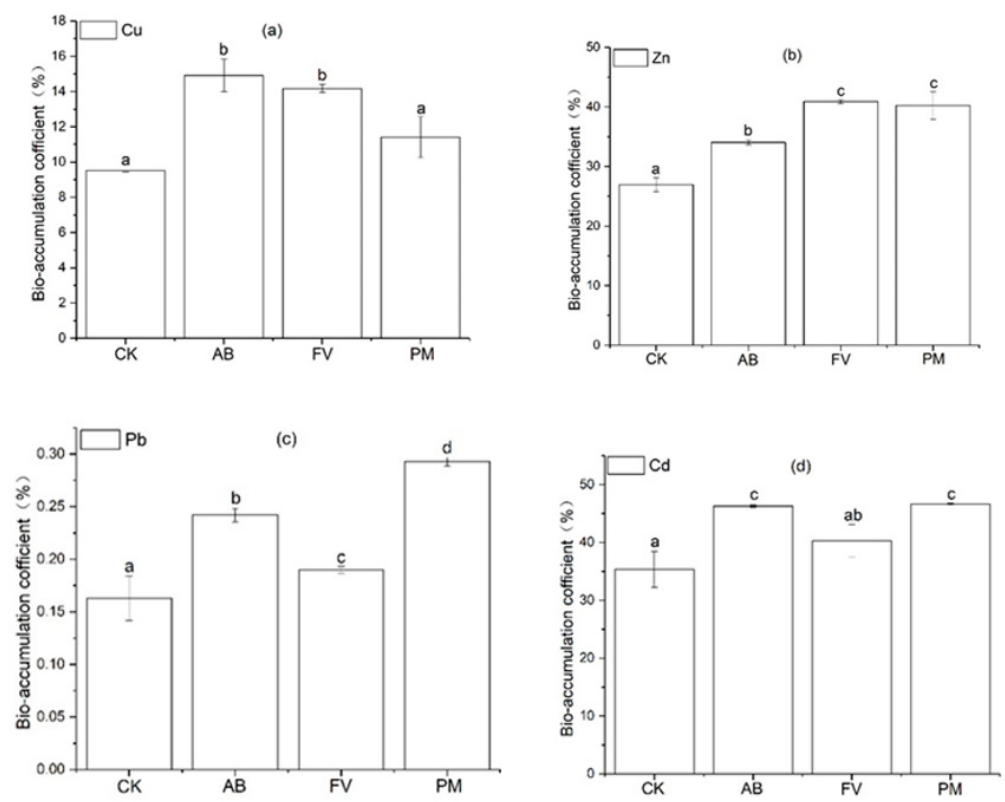
Figure 11. ( a ) BAC of Cu in the brown rice of the different treatments; ( b ) BAC of Zn in the brown rice of the different treatments; ( c ) BAC of Pb in the brown rice of the different treatments; ( d ) BAC of Cd in the brown rice of the different treatments. Data are expressed as means ± SD; n = 3. Different letters on data in the same group indicate a significant difference between them at p < 0.05 level.